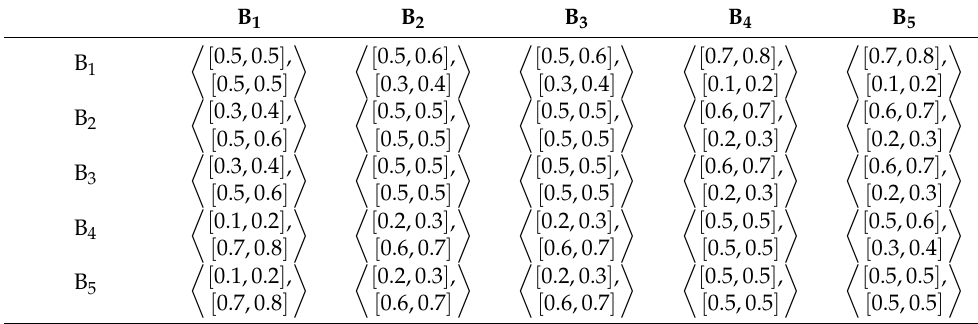
Table 15. Aggregated decision interval matrix in IVPF–AHP for the sub-criteria B (CI = 0.0234898, CR = 0.0209731). B 1 B 2